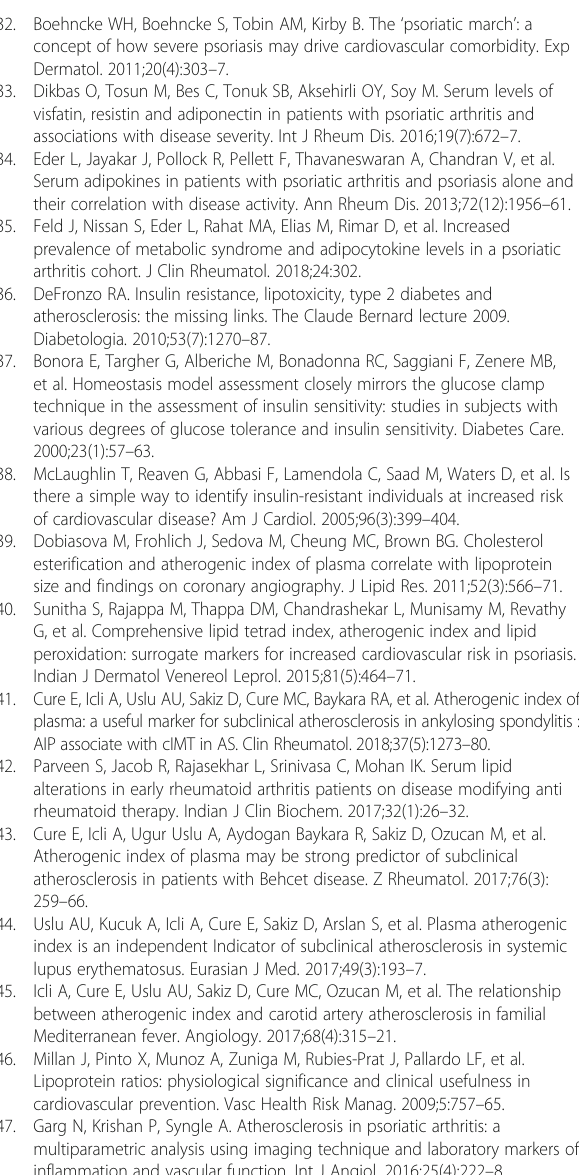
Classification criteria for psoriatic arthritis: development of new criteria from a large international study. Arthritis Rheum. 2006;54(8):2665 – 73. 24. Dobiasova M, Frohlich J. The plasma parameter log (TG/HDL-C) as an atherogenic index: correlation with lipoprotein particle size and esterification